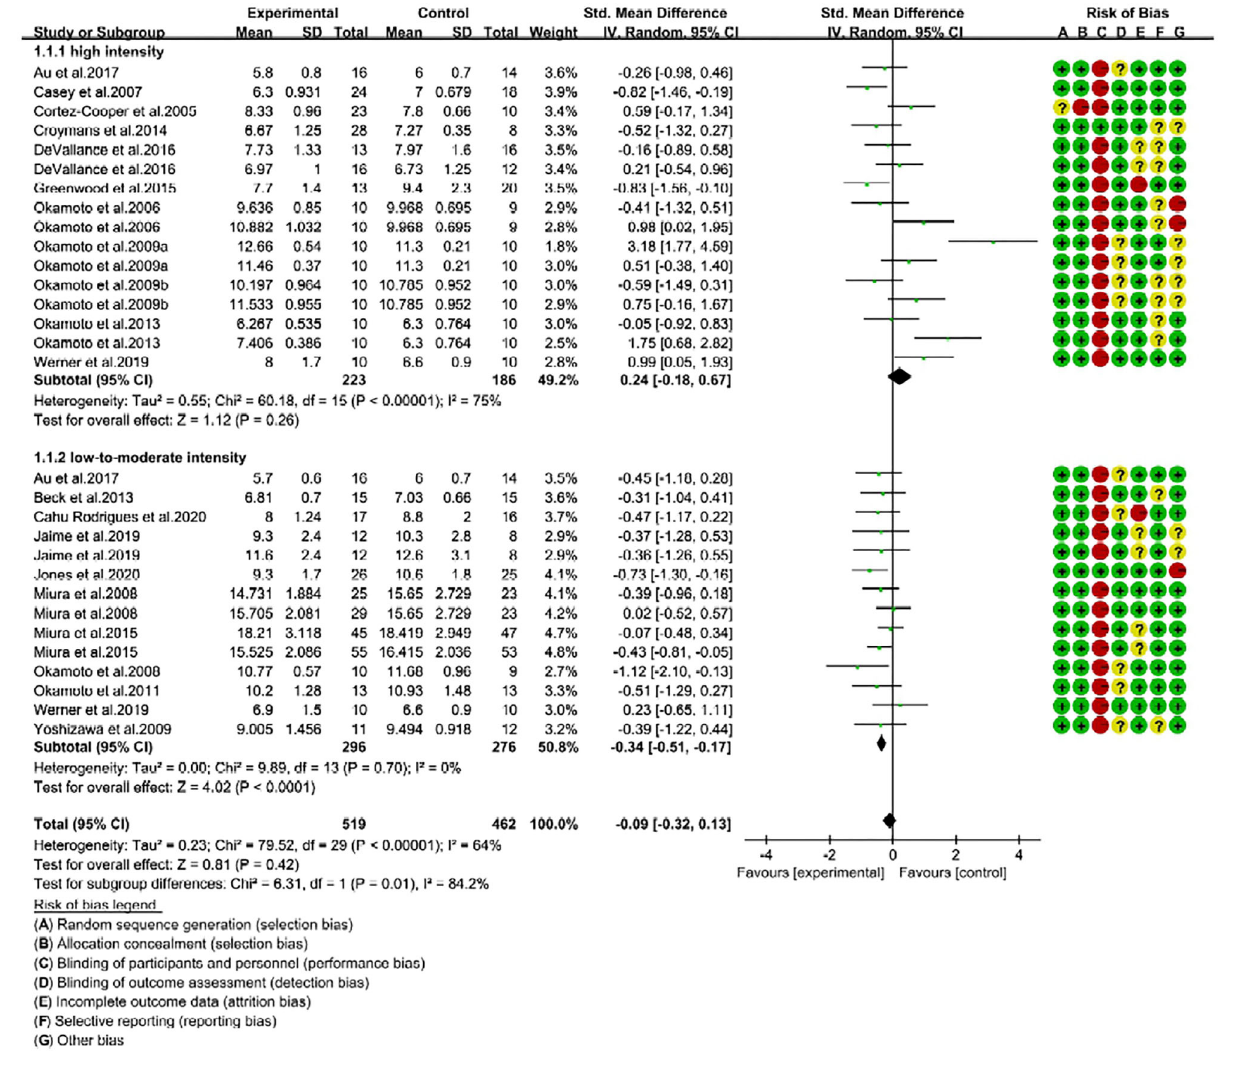
duration of RE intervention was between 8 and 12 weeks with a frequency of 1–5 times per week. The intensity of RE (%1-RM) ranged from 30 to 90% 1-RM, and sets of repetitions ranged from 3 to 25. The characteristics of participants and RE intervention along with publication details were summarized in Table 1